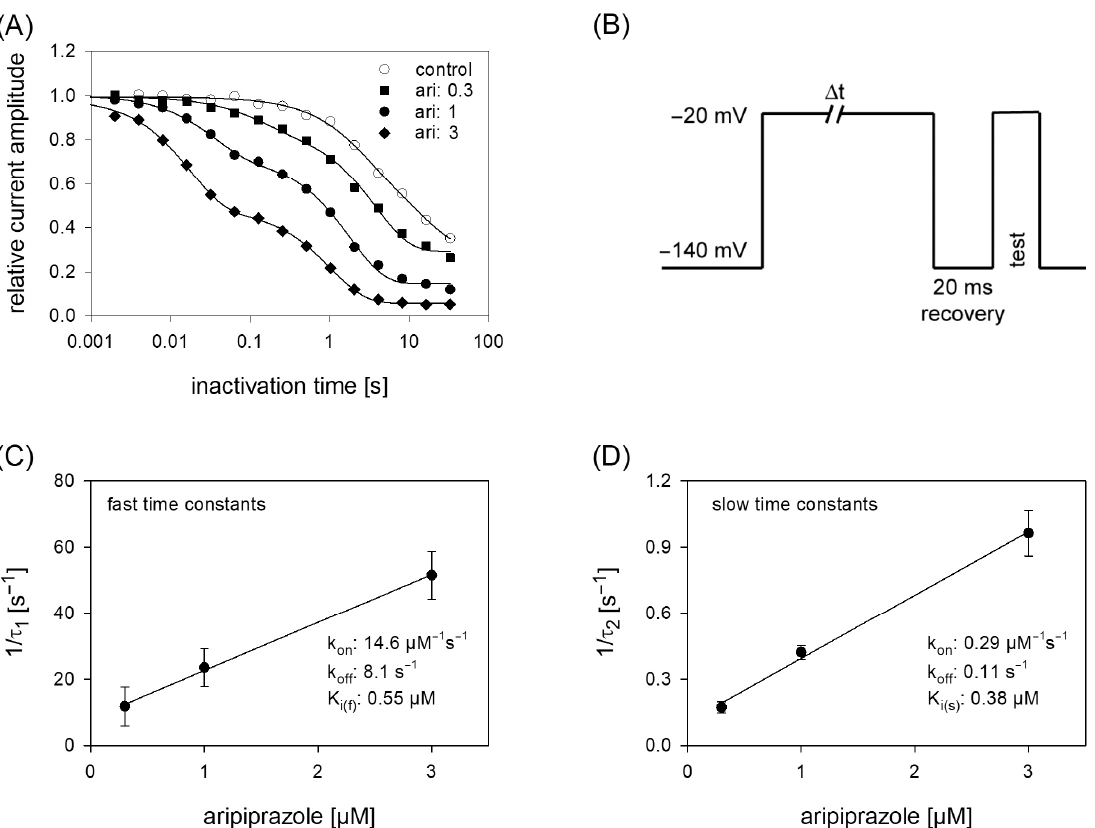
Figure 6. Time course of block development. ( A ) The graph illustrates relative current amplitudes in dependence on the duration of the inactivating prepulse for control (open circles) and in the presence of different concentrations of aripiprazole (filled symbols). Solid lines represent fits of single (control) or double exponential functions (in the presence of aripiprazole). ( B ) Experimental scheme for an individual sweep. Channels were inactivated at − 20 mV for a variable duration. Immediately before the test pulse a short recovery period was inserted. The amplitude of the inactivating current was used as control. Interval between individual sweeps was 5 s. ( C , D ). The inverse of the time constants of the data shown in A were plotted versus the concentration of aripiprazole. Association (k on ) and dissociation rate constants (k off ) were estimated from the slope and y-intercept of the linear fit. Inserts give fit data for this particular experiment. Altogether affinity constants for the fast and slow time constants were 0.55 µ M and 0.38 µ M, respectively. This evaluation was performed under the reservation that the data from the individual terms were allowed to be handled separately, as mentioned in the